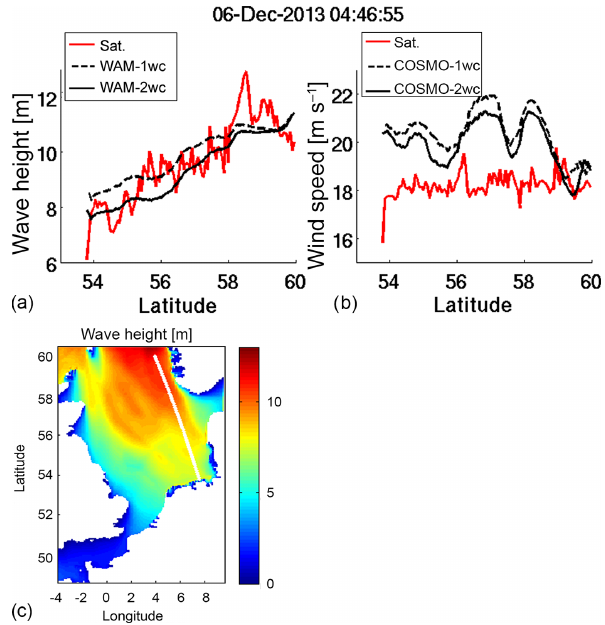
Figure 7. As Fig. 6 but for storm Xaver on 6 December